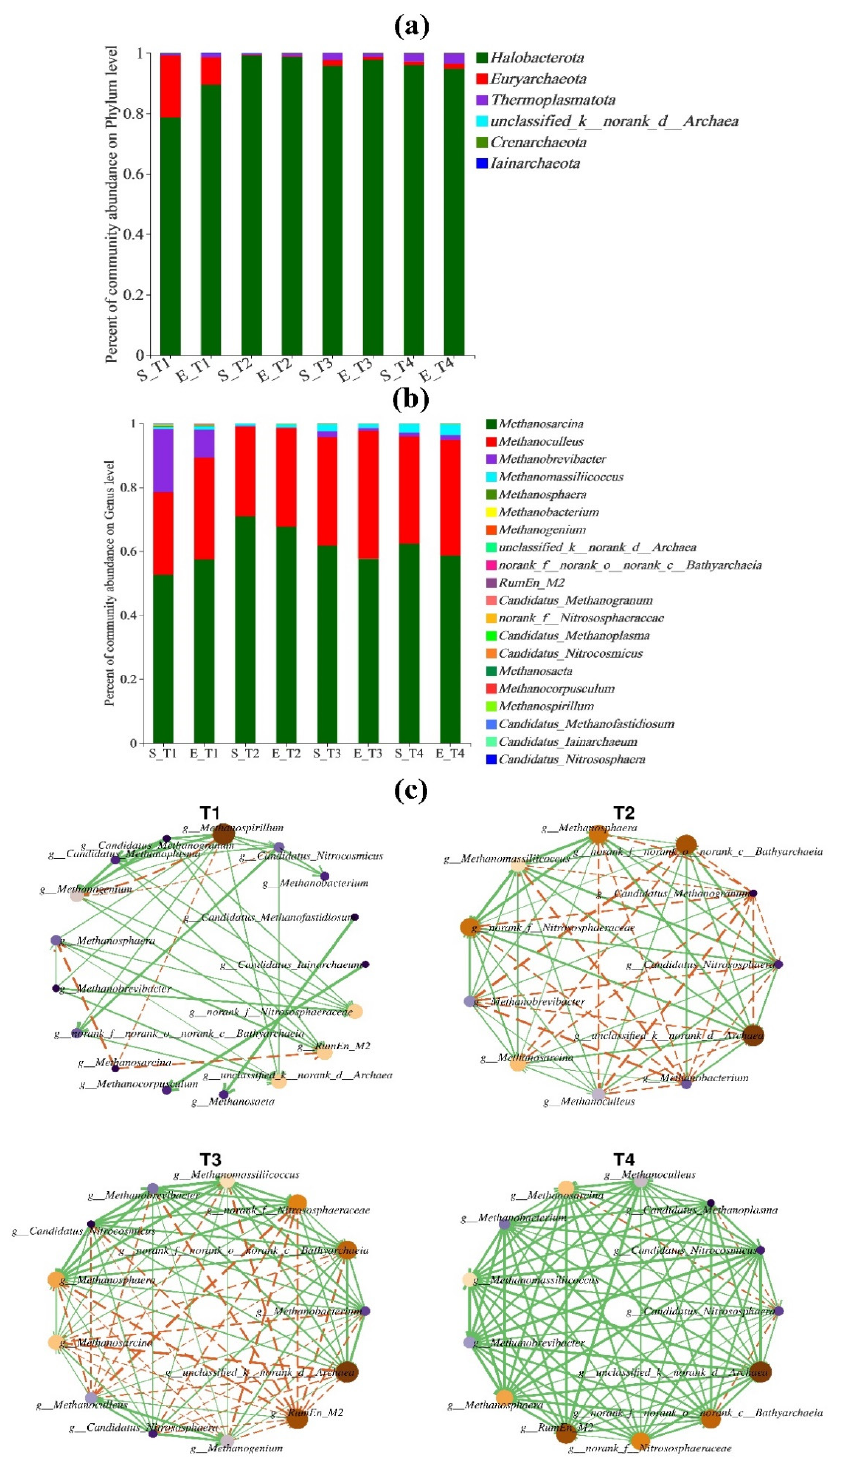
Figure 7. Analysis of archaeal community, based on ( a ) community structure on the phylum level, ( b ) community structure on the genus level, and ( c ) co-networks.